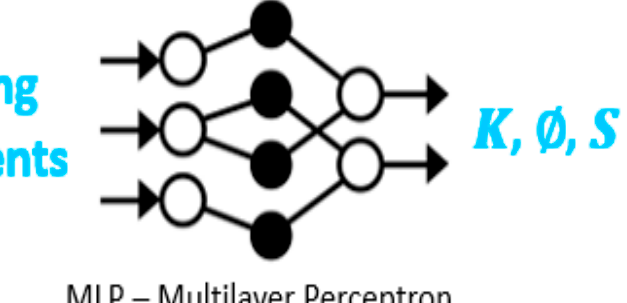
Figure 19. Scheme of the neural network. Source: authors.